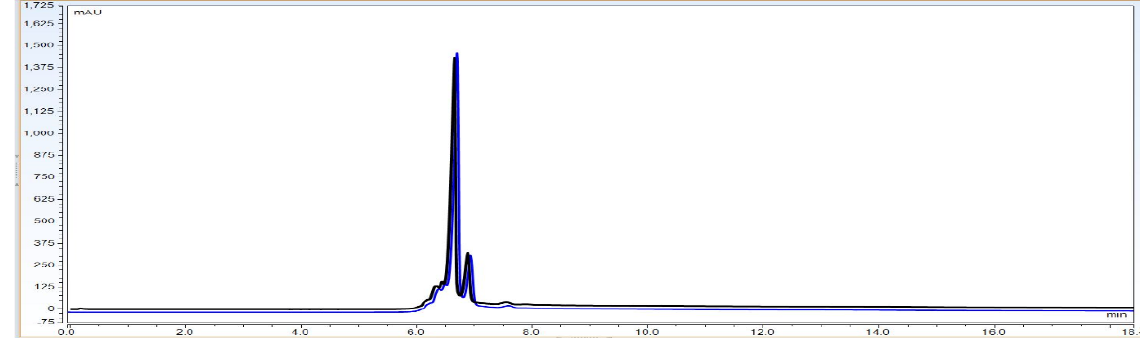
Figure 10. Robustness experiment overlay of Bevacizumab sample (3.0 mg/mL concentration) on CEX UPLC system at 0 time point and 48 h kept in auto sampler with the same mobile phase.